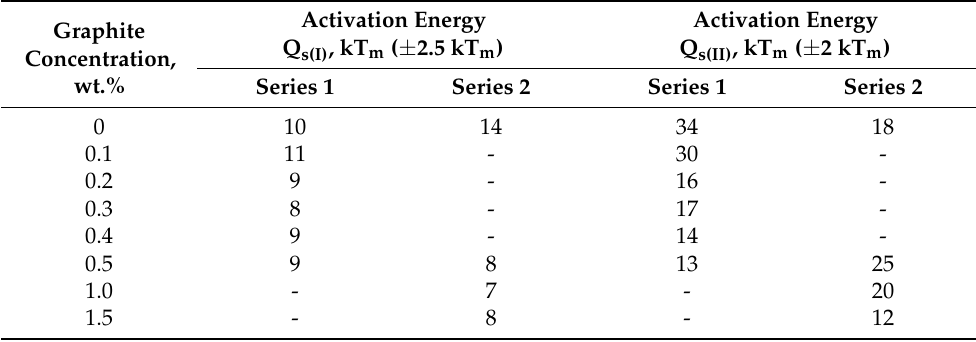
Table 4. Impact of carbon concentration on activation energies of first and second stages of the non-isothermal solid-phase sintering of WC-10%Co powders.